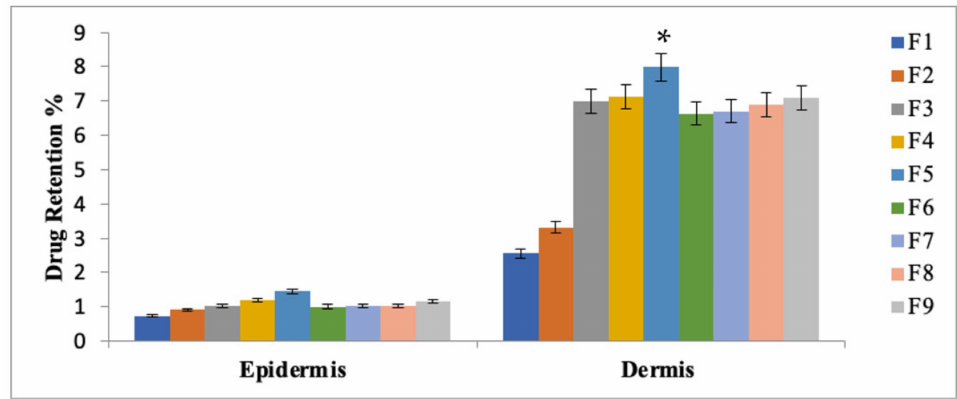
Figure 5. Skin drug retention of MTX patches. Data are expressed as mean ± SD; n = 3, one-way ANOVA followed by post hoc Tukey test ( p < 0.05), F5 vs. F1. (* p < 0.05).